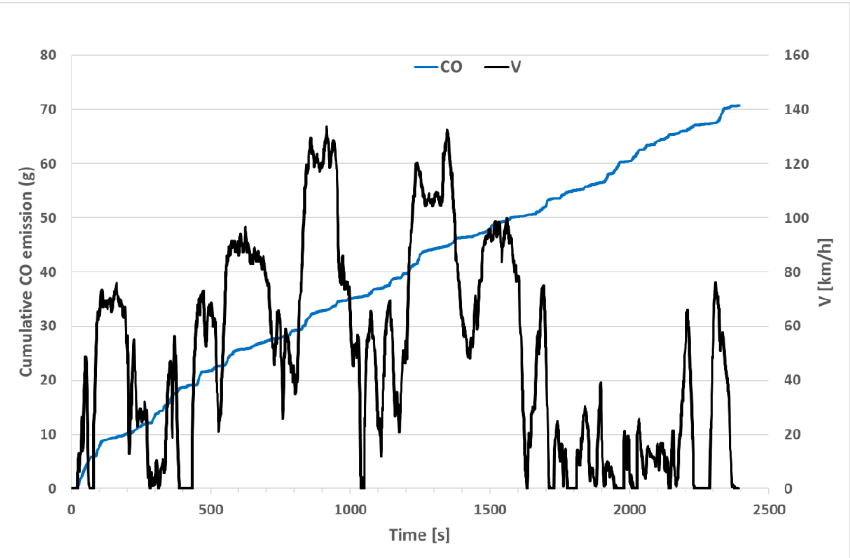
Figure 16. Cumulative CO emission versus vehicle speed in on-road test, petrol propulsion.